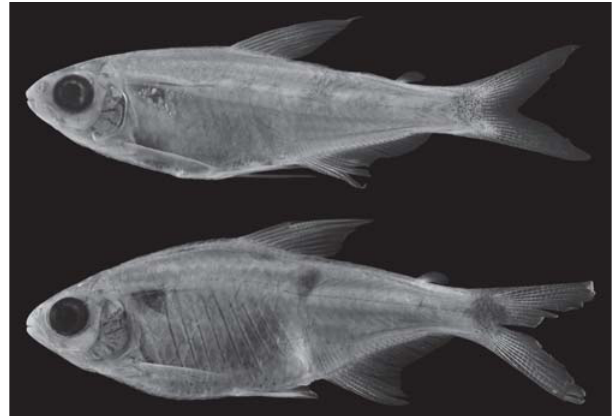
Fig. 7. Holotypes of Odontostilbe madeirae , ANSP 39193, female 32.1 mm SL (top), and Odontostilbe drepanon . ANSP 39210, male 30.5 mm SL (bottom - The darkned area below dorsal fin is a preservation artifact).